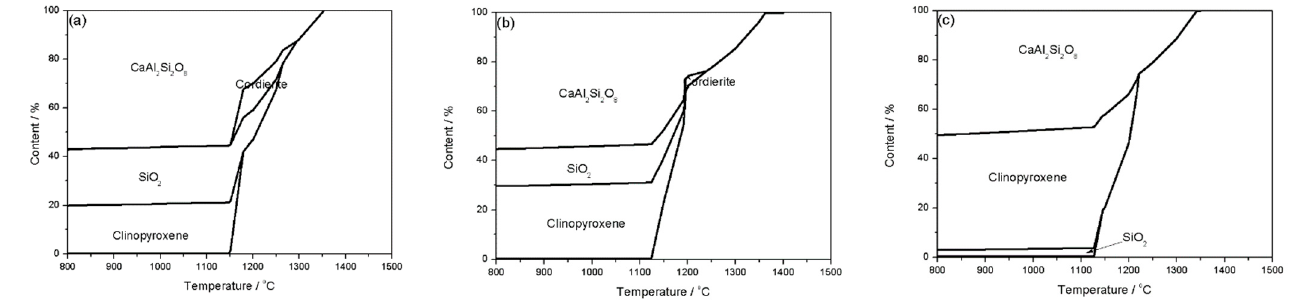
Figure 3. Mineral transformation of the blended coal of KG and SH. ( a ) SH:KG = 3:7; ( b ) SH:KG = 5:5; ( c ) SH:KG = 7:3.